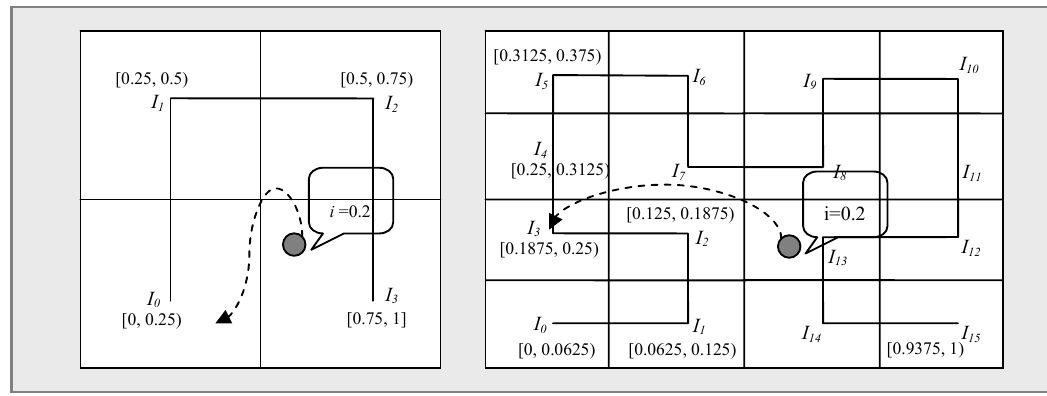
Figure 2. Level 1 and Level 2 Hilbert Curve